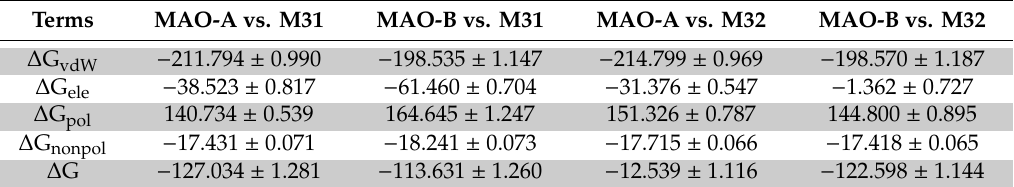
Table 2. Analysis of calculated binding free energies of four